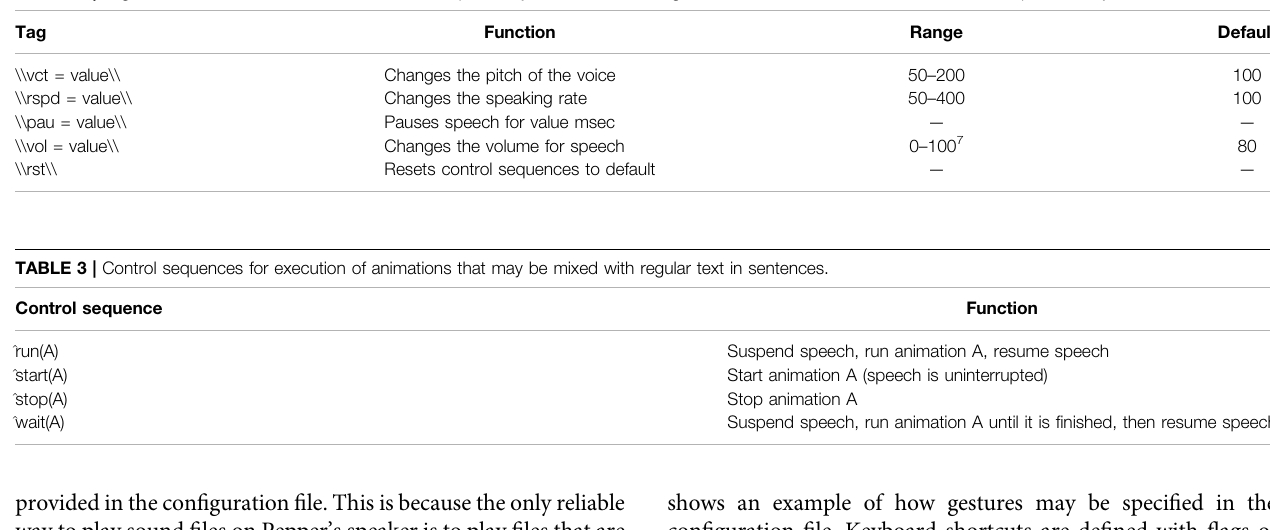
TABLE 2 | Tags that can be included in sentences to be spoken by the robot. The range and default values are standardized scales provided by SoftBank. Tag